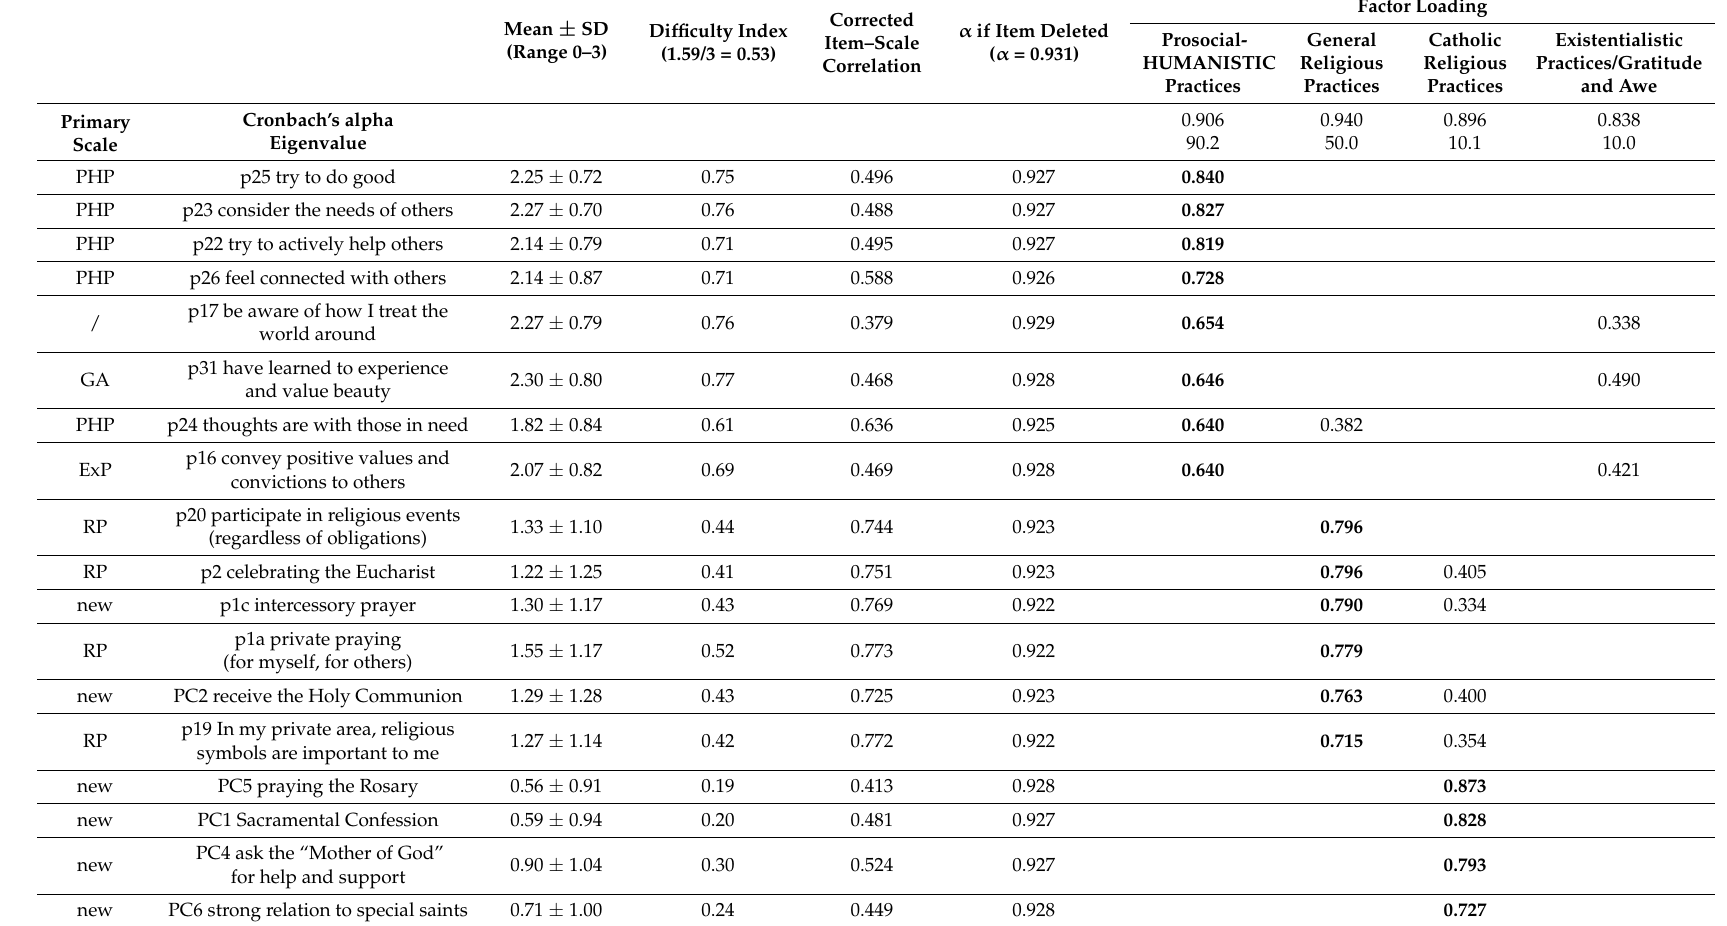
Table 3. Reliability and factorial